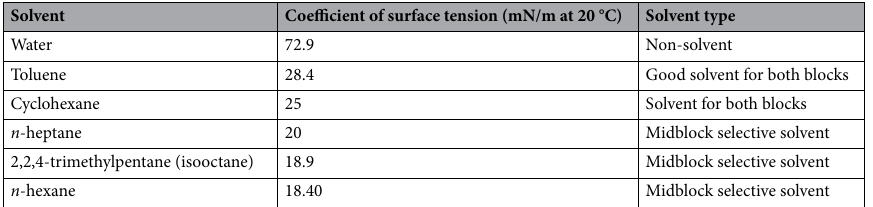
Table 1. Surface tension coefficient values 29 for possible SIBS solvents and